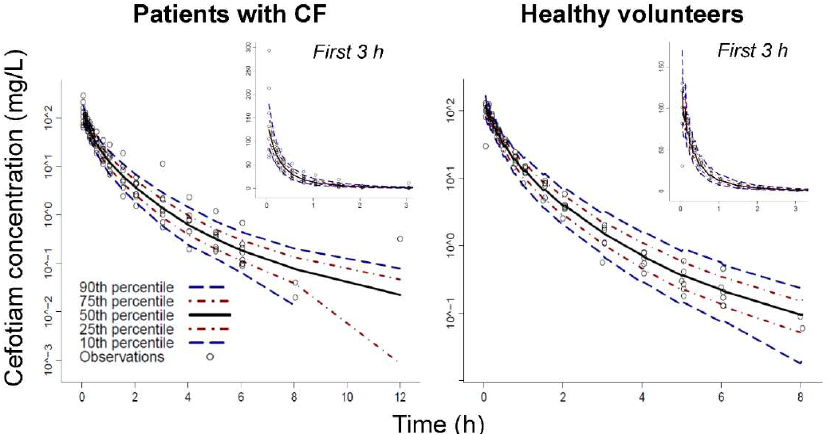
Figure 3. Visual predictive check for cefotiam concentrations in patients with CF (left) and healthy volunteers (right). The plots show the observations (markers), the 50 th percentile (i.e., median) of the model predictions (black line) along with the 80% prediction interval [10 th to 90 th percentile] and the interquartile range [25 th to 75 th percentile]. Ideally, the median of the observations and of the predictions should superimpose and 10% of the observations should fall outside the 80% prediction interval on either side.